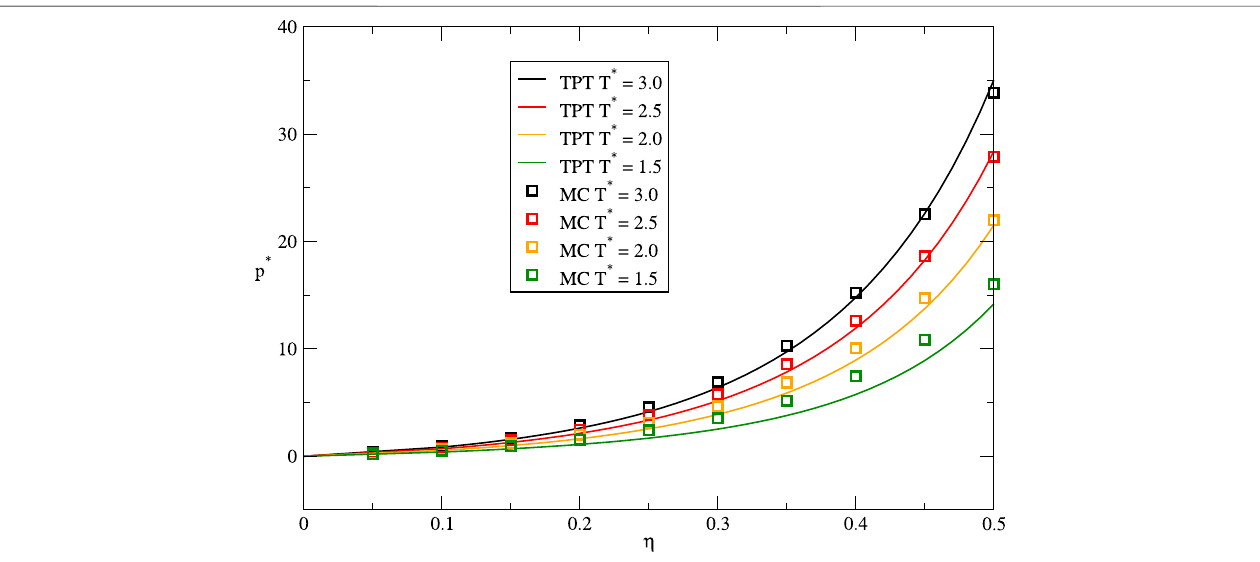
FIGURE1| Variousisothermsoftheparabolic-well fl uidfor λ (cid:2) 1 . 25.ThelabelTPTindicatesthattheresultshavebeenobtainedusingthermodynamicperturbation theory while the label MC refers to Monte Carlo simulation results.